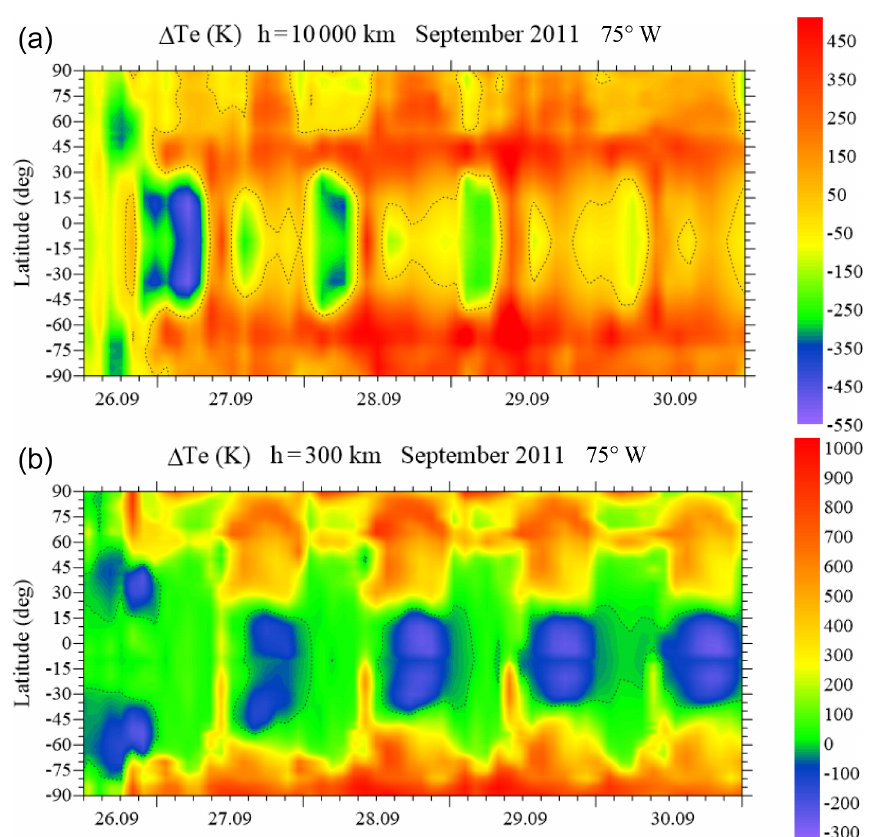
Figure 9. Behavior of the GSM TIP model-derived disturbances in the electron temperature, T e , at the height of 300km (b) and 10000km (a) during geomagnetic storms on 26–30 September 2011 at the longitude of 75 ◦ W.